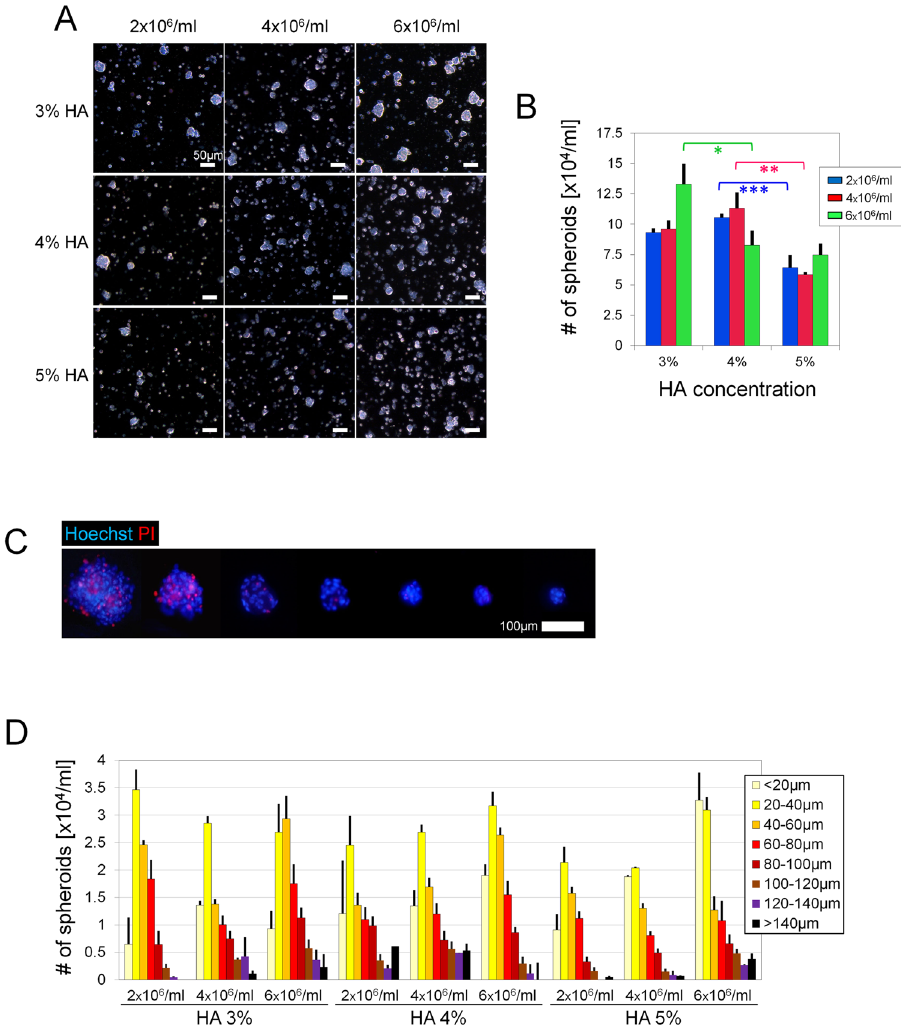
Figure 2. Optimization of spheroid preparation. ( A ) Representative microscopic images of spheroids after 12 h culture with different HA concentrations and seeding densities. Scale bars = 50 µ m. ( B ) Total numbers of spheroids ( > 20 µ m) yielded after 12 h culture. ( C ) Fluorescent microscopic images of spheroids of different sizes. Dead cells were labeled by PI (red) while nuclei were labeled with Hoechst (blue). Scale bars = 100 µ m. ( D ) Size-distribution histogram of the products; n = 3 independent experiments; 50–200 particles of product analyzed in each sample; * p = 0.008, ** p = 0.009, *** p =